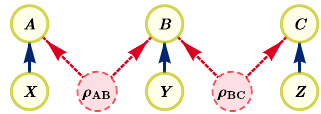
FIG. 11. The tripartite-line causal scenario, where two causally independent parties A and C each share some quantum entangle- ment with a central party B , sometimes denoted for brevity.